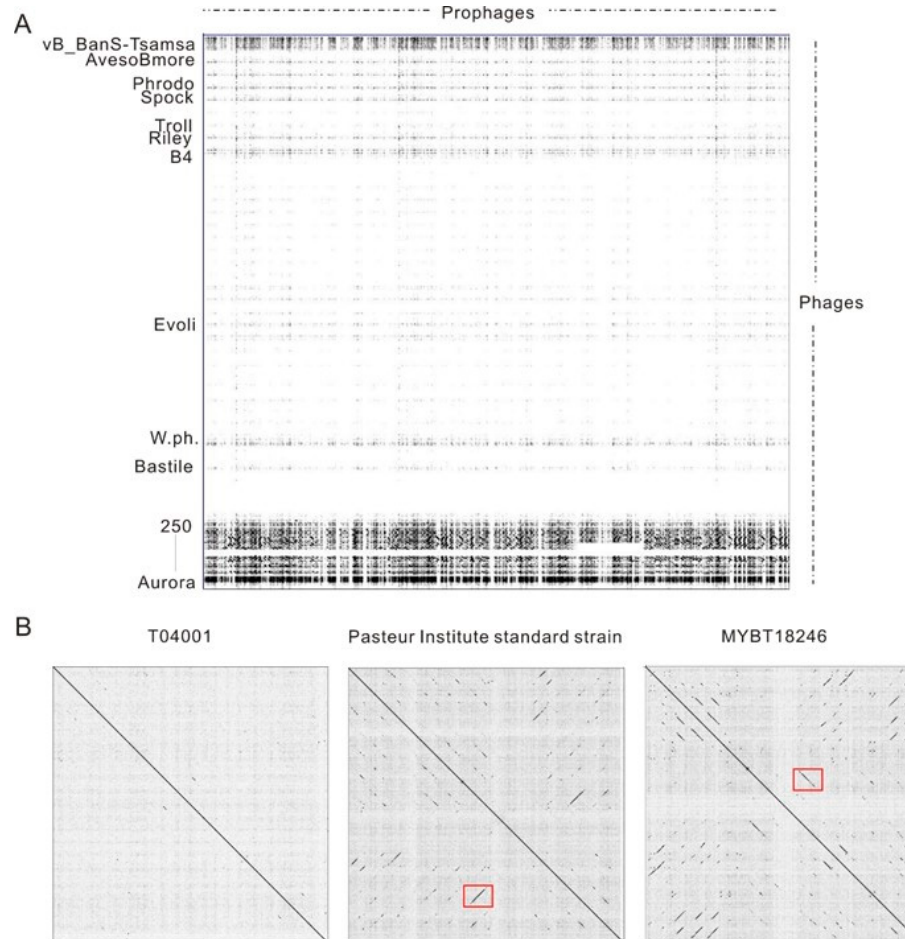
Figure3. PairwisecomparisonofprophagesidentifiedfromBtgenomesusingGepard. ( A )Comparisons of 135 putative complete Bt prophage sequences, with phages infecting Bacillus cereus group strains. The horizontal direction indicates the sequences of prophages, and the vertical direction indicates the phages sequences. Partial phages that the genome showed similarities with prophages regions were shown. The genome sequences of the 67 phages that infected the B. cereus group strains were collected from GenBank and ranked by the length of the phage genomes. This is listed in Table S4. ( B ) Pairwise comparison of all candidate prophage regions identified from the same strain. The co-linearity regions of the two red boxes mark structural